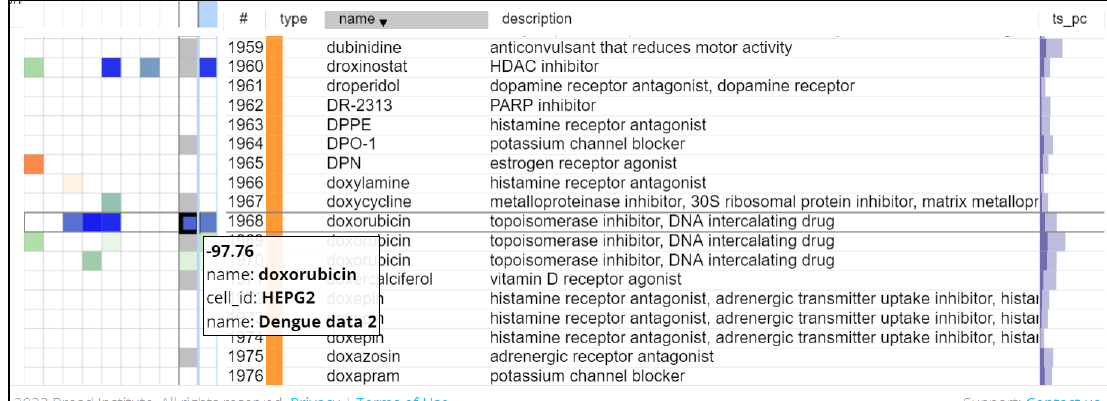
Figure 2. Snapshot of the heat map generated by querying the DHF DEGs in CMap. The blue coloured gradient indicates the negative connectivity score of the compounds with inverse gene signatures.